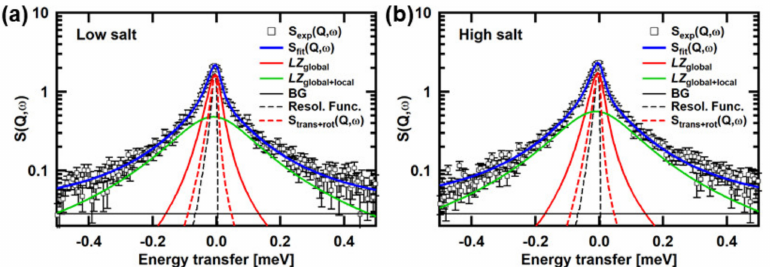
Figure 6. Examples of the QENS spectra. The spectra at Q = 1.05 Å − 1 of α Syn ( a ) in the low-salt state, and ( b ) in the high-salt state, are shown. The fits to the experimental spectra using Equation (1), the simulated spectra of S trans+rot ( Q , ω ), and the resolution function are also shown. The experimental spectra shown were obtained from the measurements carried out during the study described in